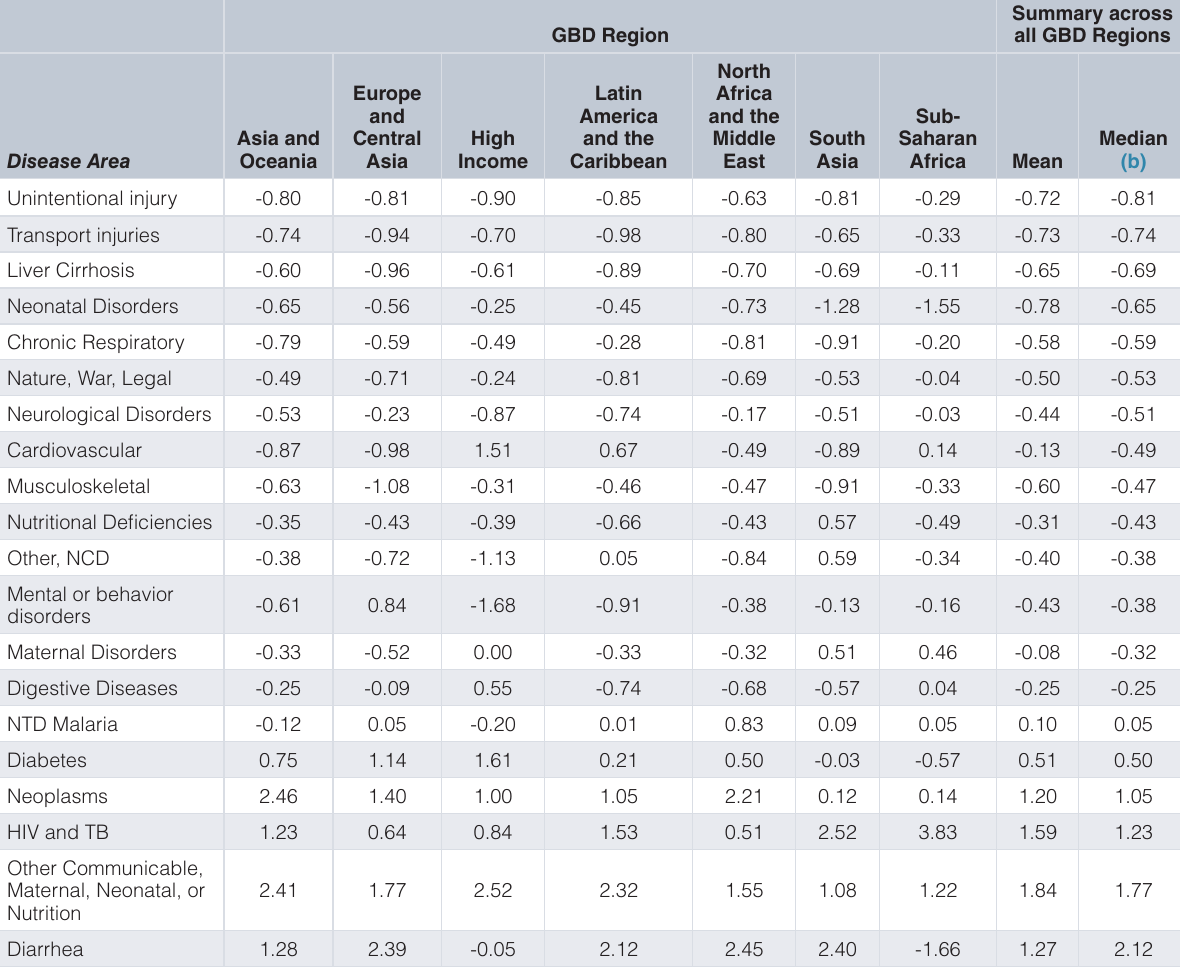
Table 2. Standardized residual deviation from projected number of studies for each disease, by GBD region.